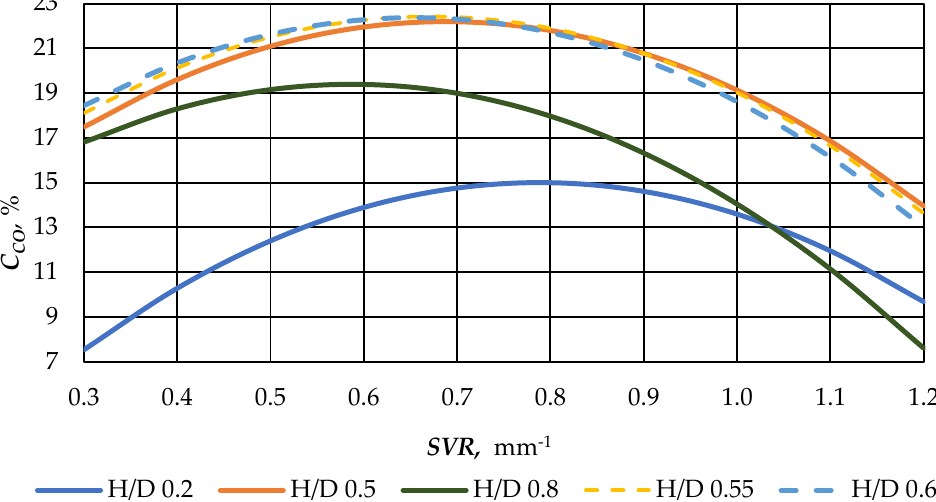
Figure 6. Graphic image of the dependence of CO concentration in the received gas on the ratio of the full side area ( S ) to the volume ( V ) of a fuel fraction ( SVR ).